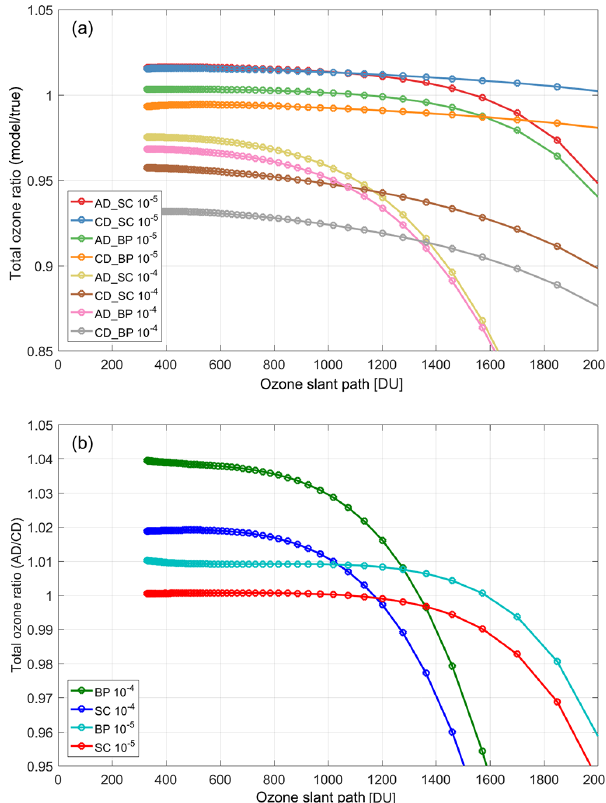
Figure 6. (a) The ratio of total ozone retrieved from modeled Dob- son AD and CD pairs using BP and SC cross sections with different levels of stray light (10 − 4 and 10 − 5 ) to true ozone as a function of OSP. (b) The ratio of total ozone retrieved from AD to CD wave- length pairs. The adjusted coefficients recommended by WMO are used to derive the total ozone amounts for these models. The ETC values calculated using the Langley method for ideal instruments are used here as